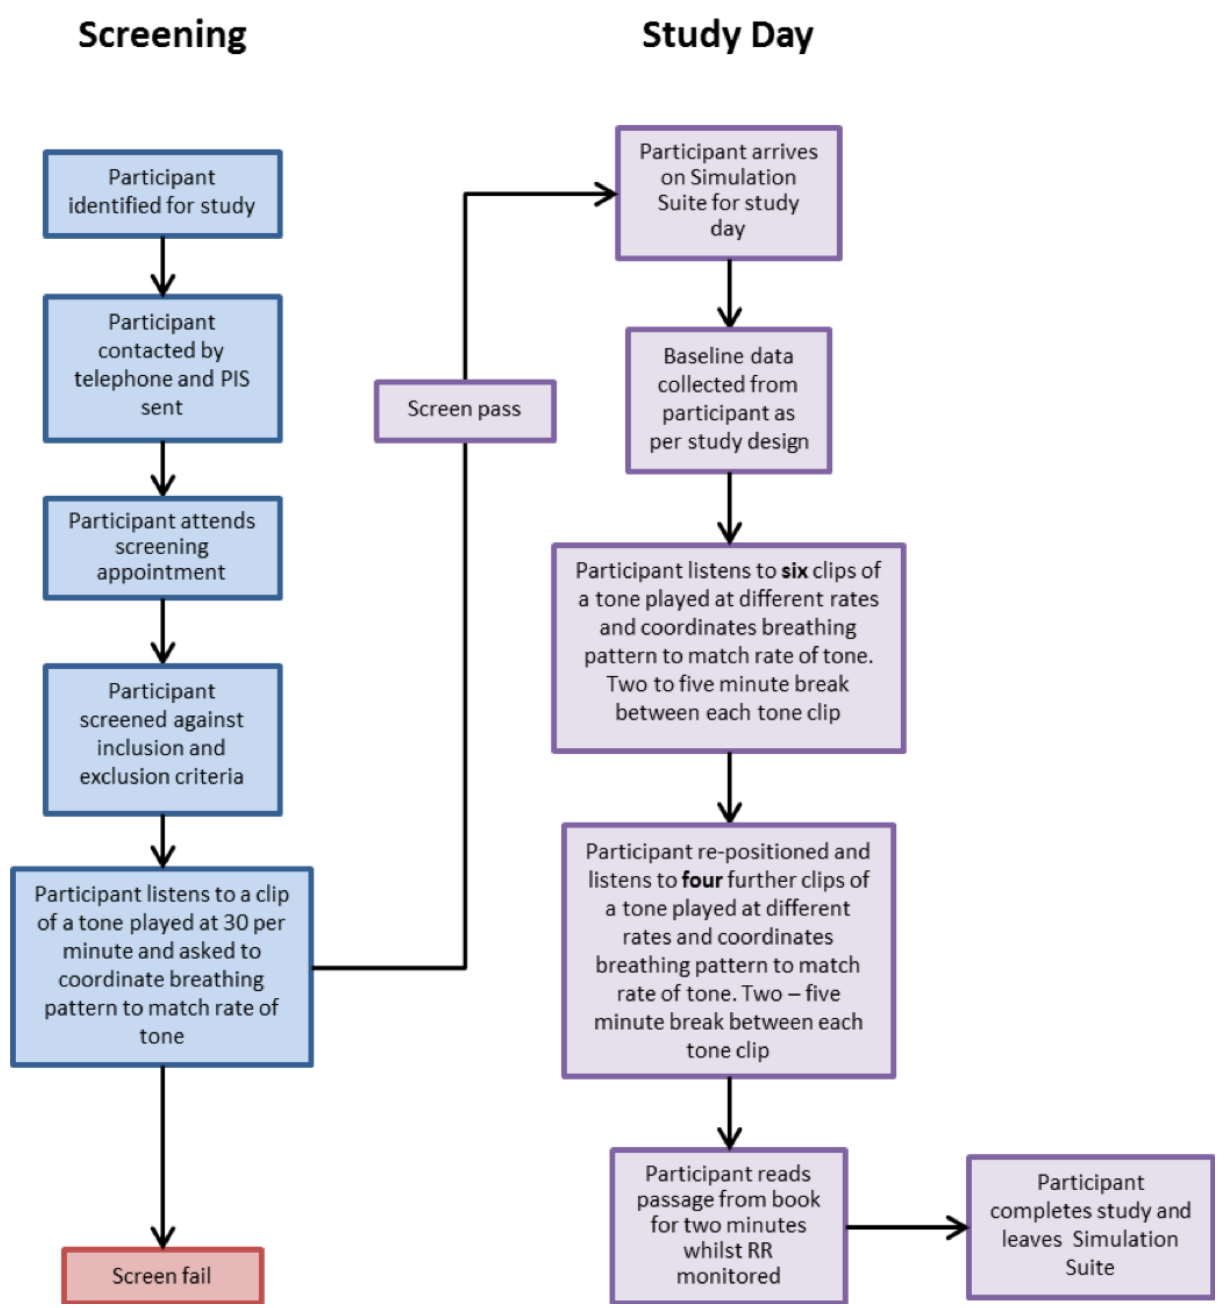
Figure 1. Participant process flow